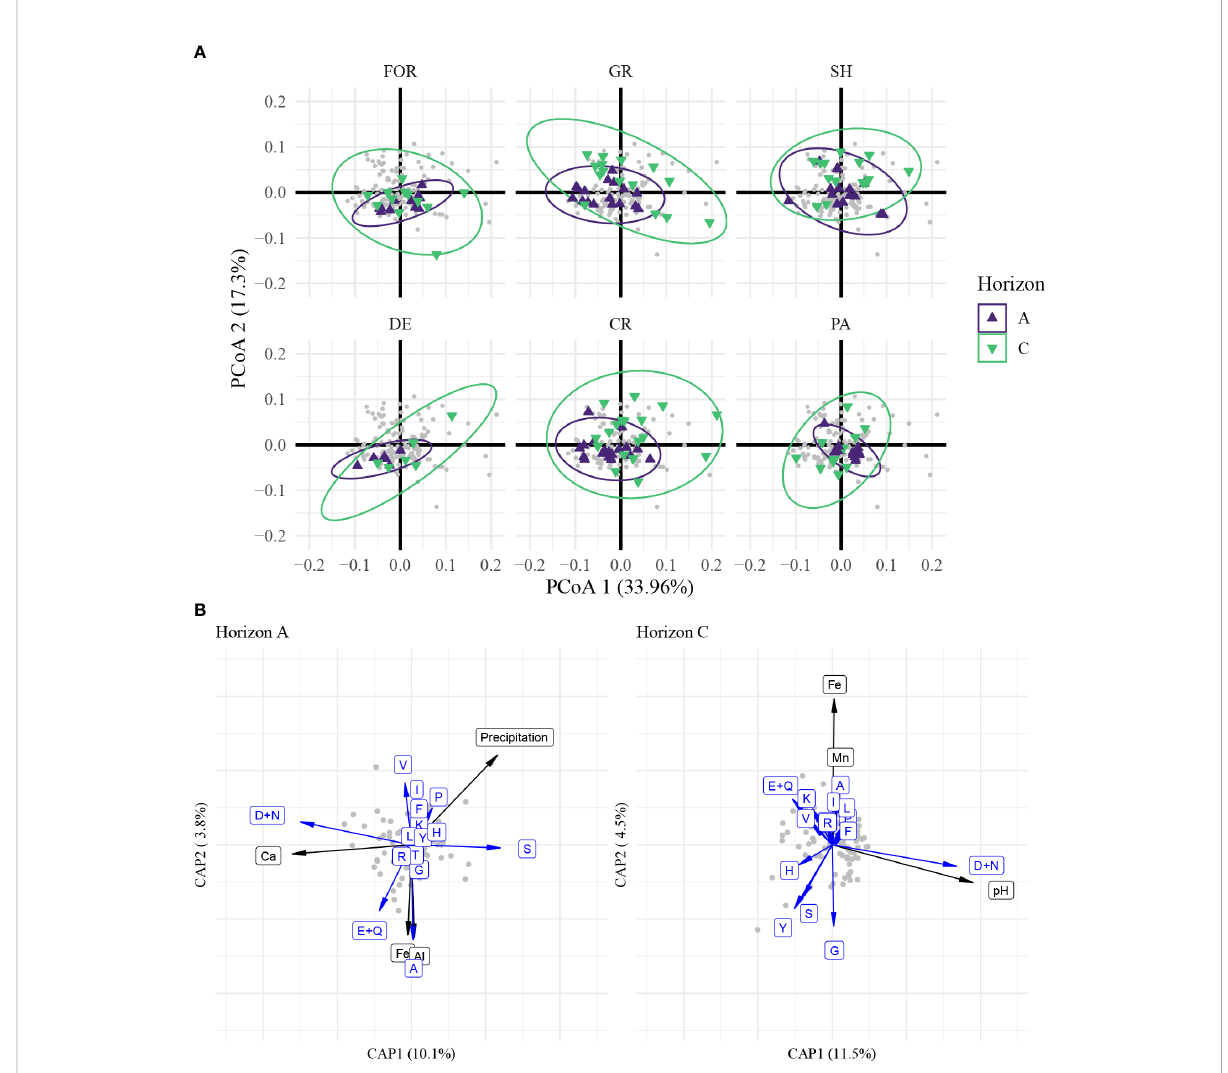
FIGURE 4 Molecular diversity and environmental factor changes under the in fl uence of selective decomposition of HAAs during pedogenesis, revealed by multidimensional sorting. (A) PCoA-based sorting on the molar ratio of HAAs. Samples from different vegetation types were exhibited separately. Colors represent different soil layers. FOR, evergreen or mixed forest; GR, grassland/herbaceous; SH, shrubland; DE, deciduous forest; CR, small grains or crop; PA, pasture/hay. Samples from fallow or low intensity residential are not shown here due to the small sample size. (B) Driving factors of HAAs in different soil layers exhibited by dbRDA. A-horizonal and C-horizonal samples were fi tted separately to compare the changes in environmental factors. The single letters in blue represent the corresponding amino acids. A, Ala; R, Arg; G, Gly; H, His; I, Ile; L, Leu; K, Lys; M, Met; F, Phe; P, Pro; S, Ser; T, Thr; Y, Tyr; V, Val; D, Asp; N, Asn; E, Glu; Q, Gln. Black labels represent speci fi c environmental factors. Data were transformed by log1p (HAAs) or log (environmental